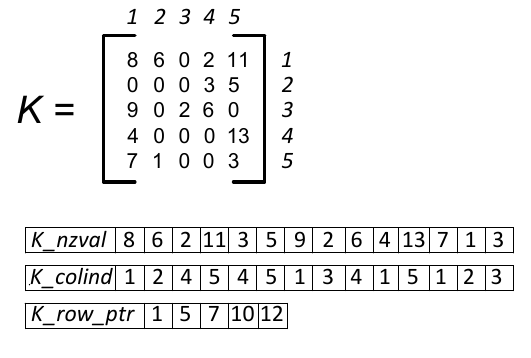
Figure 1. The compressed row format of matrix